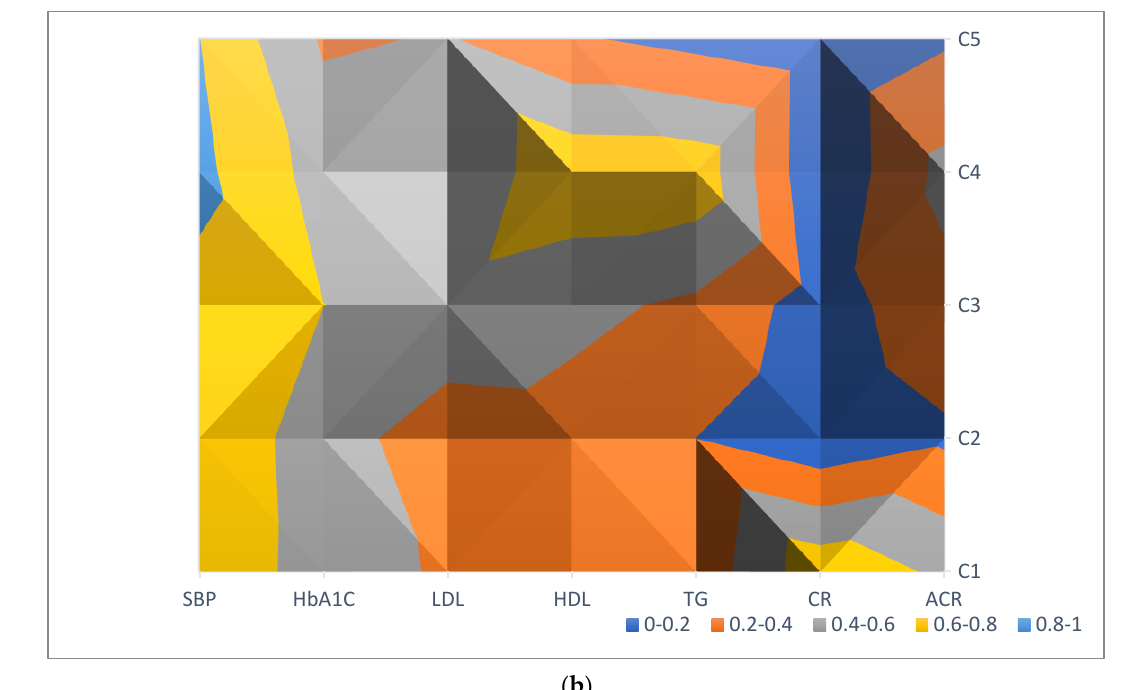
Figure 1. Surface chart of the percentile of indicators from the response frontier for the survey items and normal biomarker levels among the groups. ( a ) Distribution of the participants’ self -manage- ment assessment results from the survey. ( b ) The participants’ normal biomarker levels (2013– 2019) obtained from the health information system of a hospital.